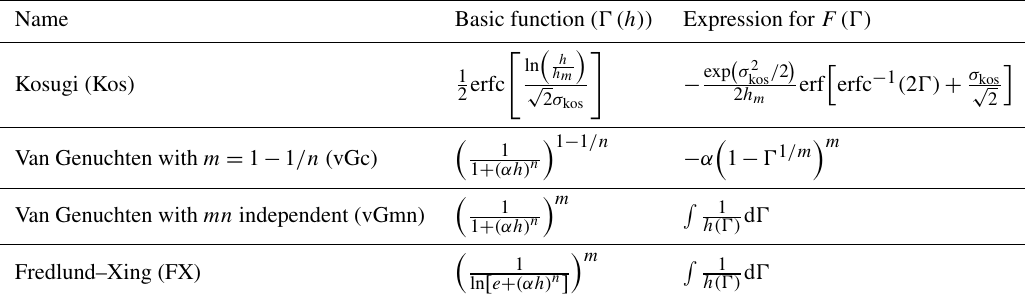
Table 2. Summary of the basic water retention functions used in the PDI scheme (see Appendix A1) as well as the analytical solutions for F (Eq. 19) as given in Peters (2014). The parameters α , n , m , σ kos , and h m are shape parameters, and e is the Euler number. In the case of FX and vGmn, no analytical solution for the integral in Eq. (19) is known, and F must be evaluated